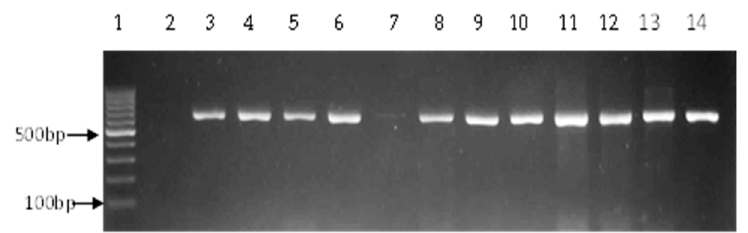
Figure 1. Representative gel showing the 663 bp 16S rRNA PCR amplified gene for confirmation of Vibrio isolates. Lane 1: molecular weight marker (100 bp), lane 2: negative control, lane 3: positive control (ATCC 17802), lanes 4–6 and 8–14: positive isolates, lane 7: negative isolate.